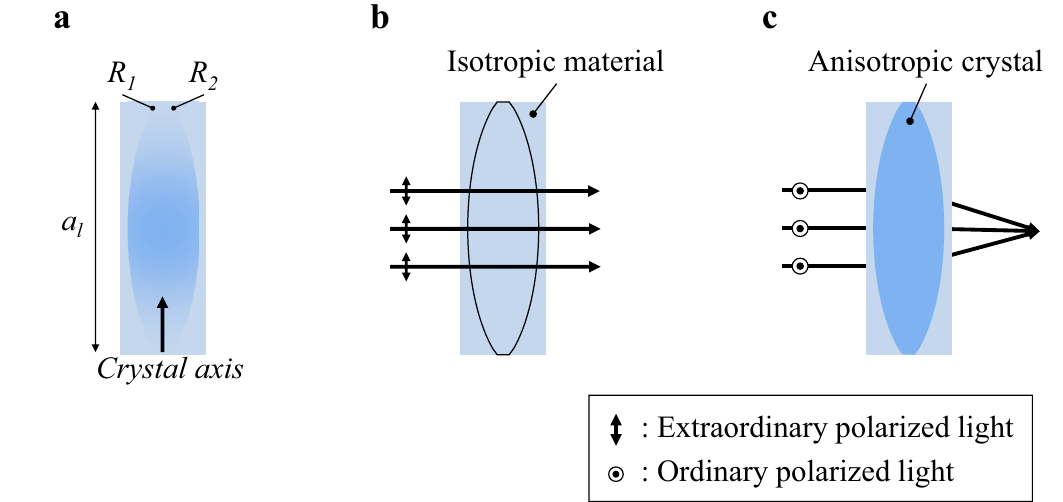
Figure 2. The principle of the IMACL: ( a ) the basic structure of the IMACL, ( b ) when the input polarization is matched to the extraordinary axis of the anisotropic crystal lens (see-through mode), and ( c ) when the input polarization is matched to the ordinary axis of the anisotropic crystal lens (lens